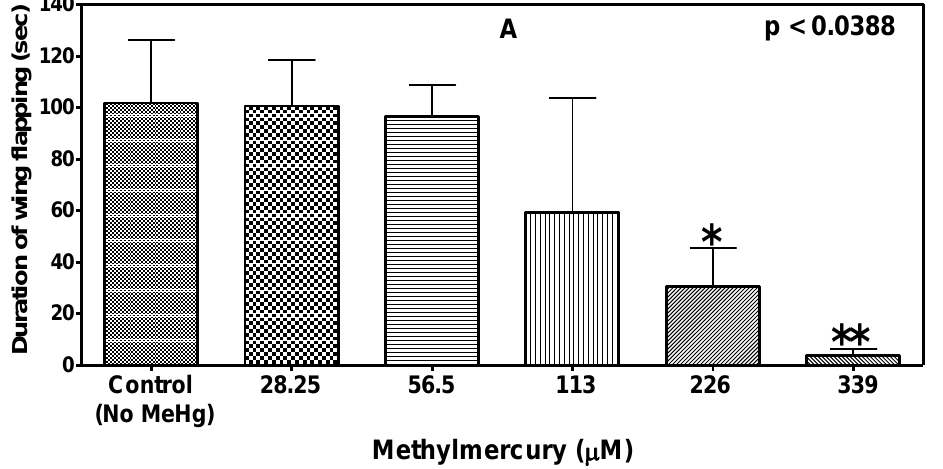
Figure 1. Effect of MeHg in the diet on duration of wing flapping by male flies. Duration of wing flapping during copulation was affected by MeHg exposure in a concentration-dependent manner ( p < 0.0388, ANOVA). Data are presented as Mean ± S.E.M of four independent experiments. * p < 0.05, ** p < 0.01 as compared to controls.